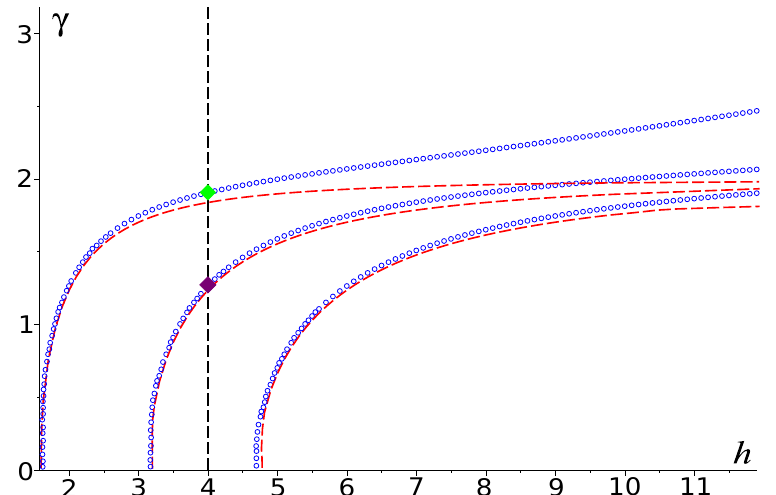
Figure 2. Dispersion curves of problems α = 0) shown by red dashed lines; purple and green diamonds are eigenvalues of problem . Q